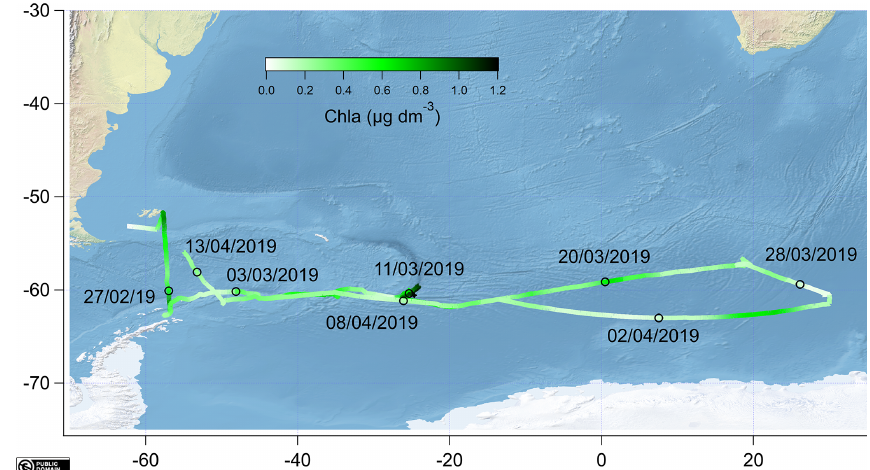
Figure 1. Map showing the cruise track coloured by underway chlorophyll a (chl a ) with sampling dates indicated as black circles. All the data were created from public domain GIS data found on the Natural Earth website (http://www.naturalearthdata.com, last access: 8 May 2020). They were read into Igor using the Igor GIS XOP beta.